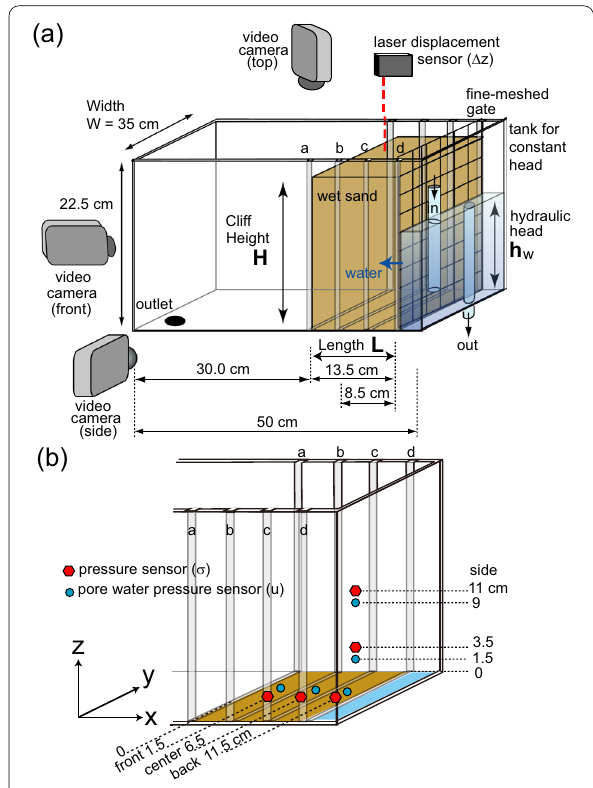
Fig. 2 An experimental setup for cliff landslides. a An acrylic box with slots “a”–“d” with a thickness of 1.5 cm for the gates. A laser displacement sensor is positioned above the centerline of the cliff at a distance of ∼ 1.5 cm from the cliff face. b Locations of the pressure sensor (measures the σ ) and pore water pressure sensor (measures the u ) pairs. 3–4 pairs (a total of 6–8) of these sensors are used. The sensors at the bottom (side wall) measures the pressure in the z ( y